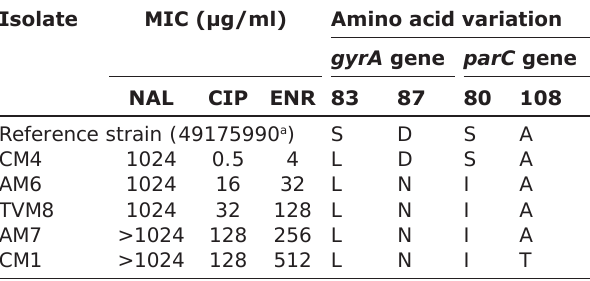
Table-3: MIC values and amino acid variations at QRDR ( gyrA and parC gene) of fluoroquinolone-resistant E. coli isolates.